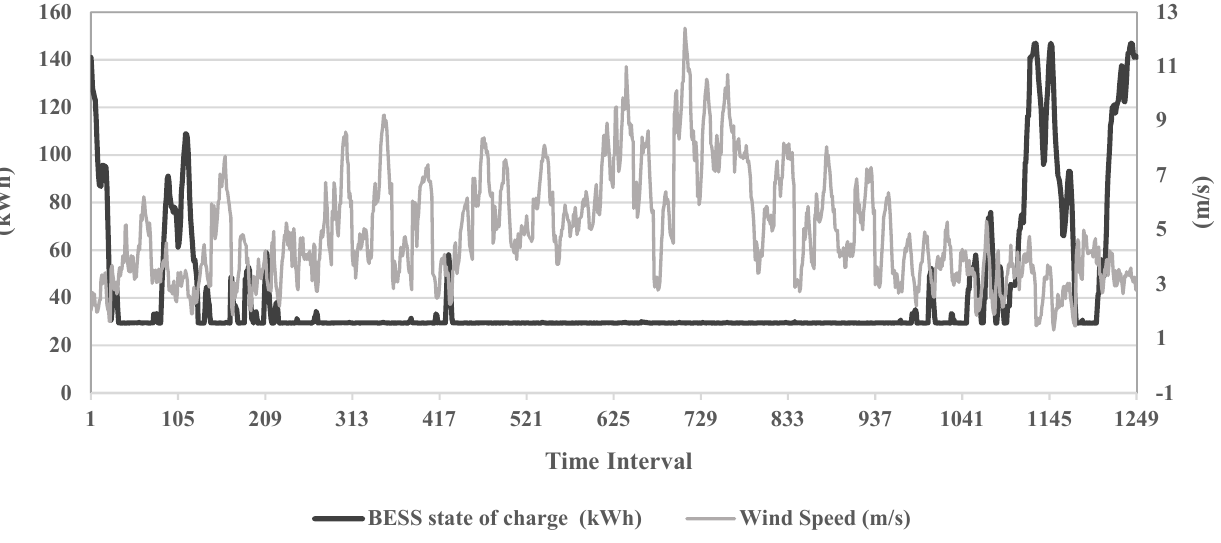
Figure 10. BESS state of charge versus wind speed.